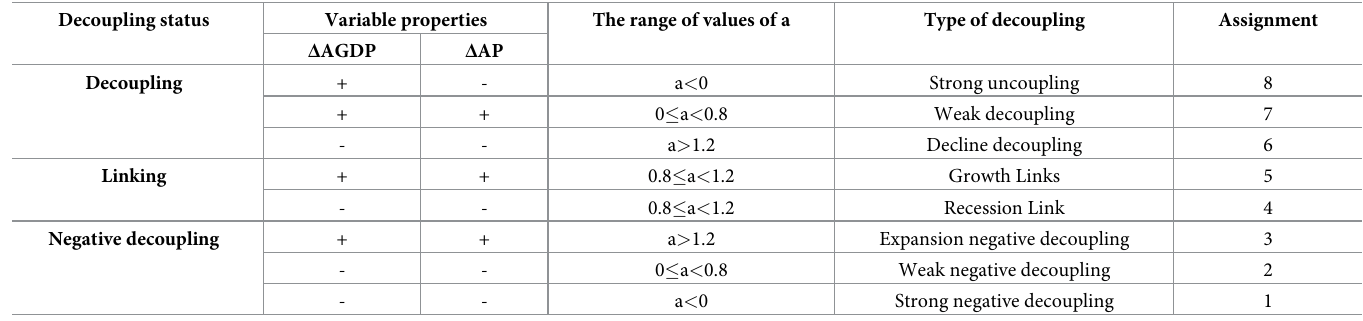
Table 3. Classification of the types of decoupling between agricultural pollution and carbon reduction and economic